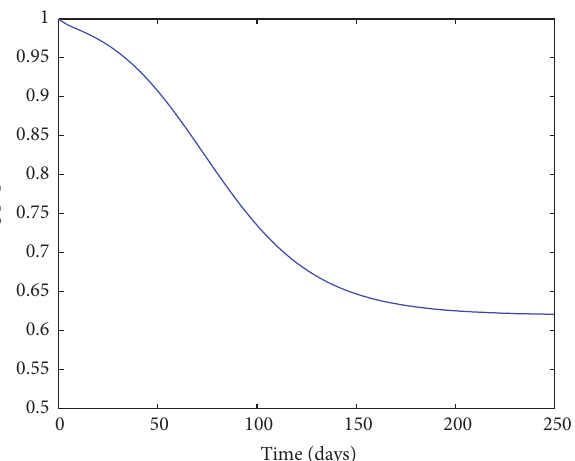
Figure 5: Evolution of the total alive population with a daily culling rate of 𝜌 𝐷 = 0.1 .